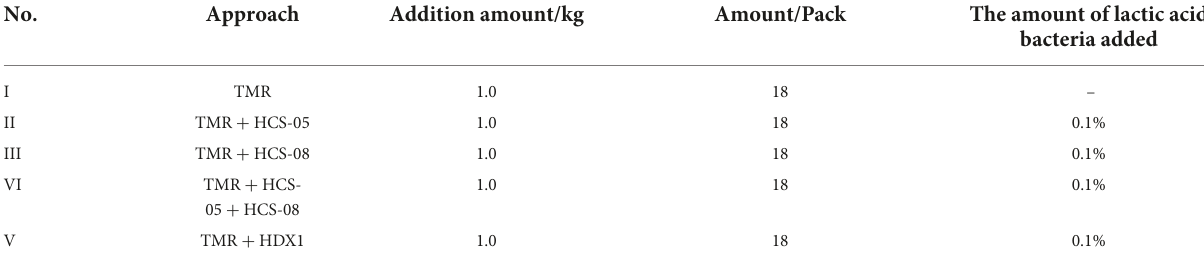
TABLE 1 Treatment method of total mixed ration